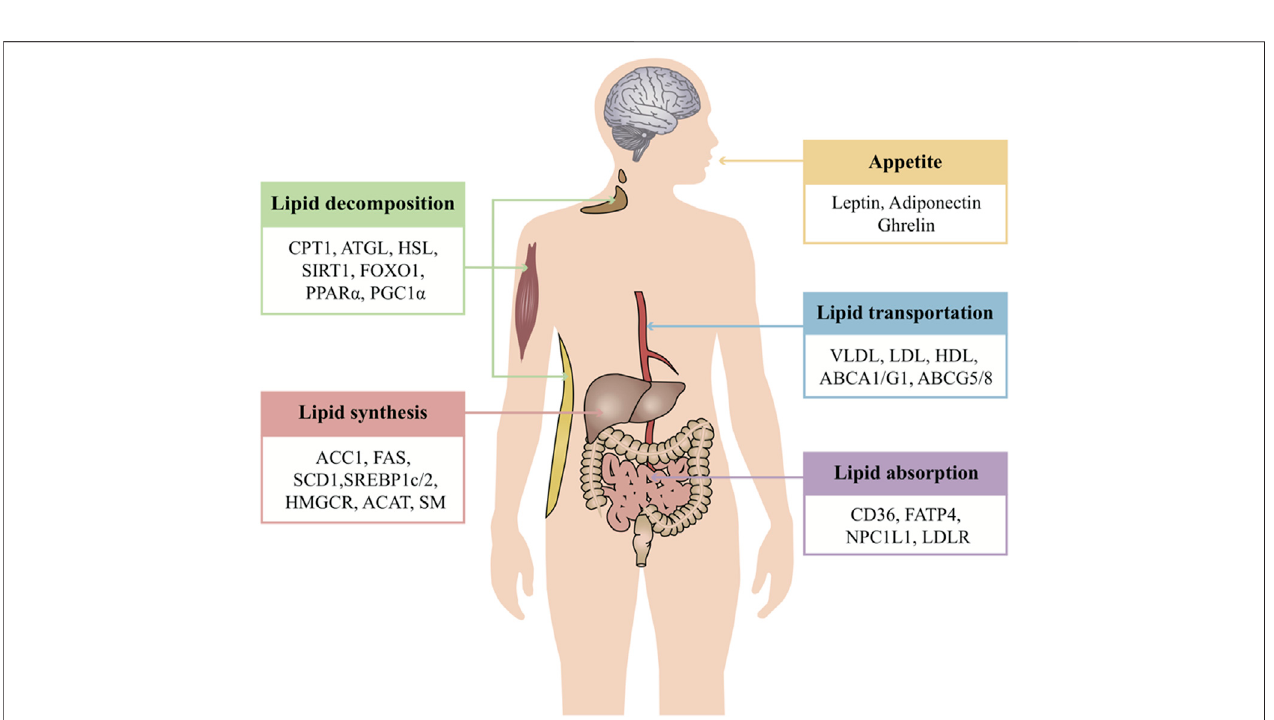
FIGURE 1 | Overview of systematic regulated lipid metabolism of TCMs. TCM treatment of obesity mainly regulates lipid metabolism from fi ve aspects: appetite, lipid absorption, lipid synthesis, lipid decomposition, and lipid transportation. Each link intersects and regulates each other to maintain the stability of the internal environment. One of the advantages of TCM is that it can act on multiple aspects and targets at the same time and systematically regulate life activities. Appetite is regulated by the level of leptin, adiponectin, ghrelin, and so on. These hormones serve as a critical signal to regulate food intake. The small intestine absorbs lipids derivedexogenouslyfromthediet.Dietaryfatcomprisesavarietyoflipids,whilelipidssynthesizedintheliverarepackagedinverylow – densitylipoproteinsanddelivered to adipose tissue for storage. CD36, FATP, NPC1L1, and LDLR are the classic regulators of lipid absorption. Apart from lipid absorption, excessive lipid synthesis is anothercauseofobesity.Someenzymesoflipidsynthesisarethekeytodiseasetreatment,suchasACC,FAS,SCD,HMGCR,SM,andACAT.Theseenzymesmayalso be regulated by the transcription factors SREBP and LXR. Cytoplasmic lipolysis and lysosomal-mediated autophagy (lipophagy) are two pathways that are known to breakdownTAGsandCEsinlipiddroplets.Inthisprocess,ATGL,HSL,andMGLbreakdownTAGsintofreefattyacidswhichthenundergooxidativedecompositionin themitochondriaviaCPT1toprovideenergy.Theactivityoftheseenzymes mayalsobecontrolledbySIRT1,FOXO1,andPGC1 α .Lipoproteinsarethemajorcarriersof lipids in circulation. The major forms of lipoproteins are chylomicrons, VLDL, IDL, LDL, and HDL. The lipoproteins are responsible for transportation of FAs and cholesterol. Furthermore, the transportation of cholesterol to the extracellular environment is controlled by ABCA1, ABCG1, and